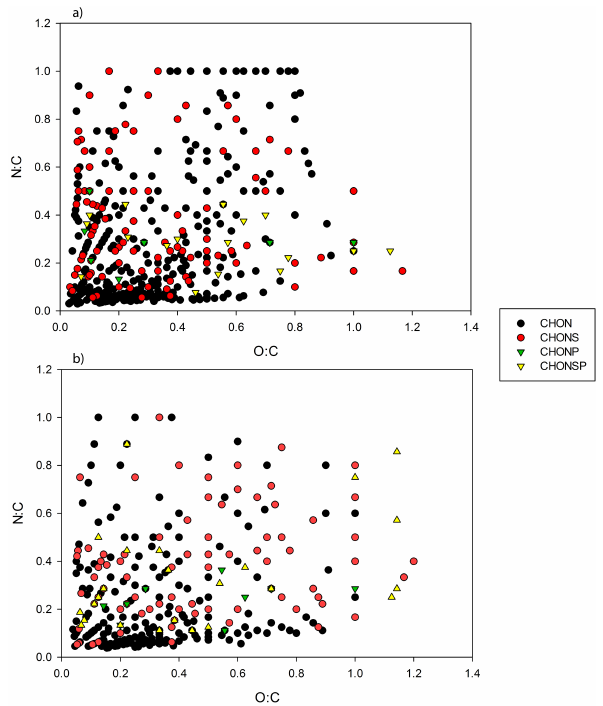
Fig. 6. (a, b) N focused van Krevelen diagram featuring elemental ratios of all N containing compounds in (a) warm season 13 July 2009 and (b) cold season 29 October 2009 marine rainwater. Leg- end denotes the compound